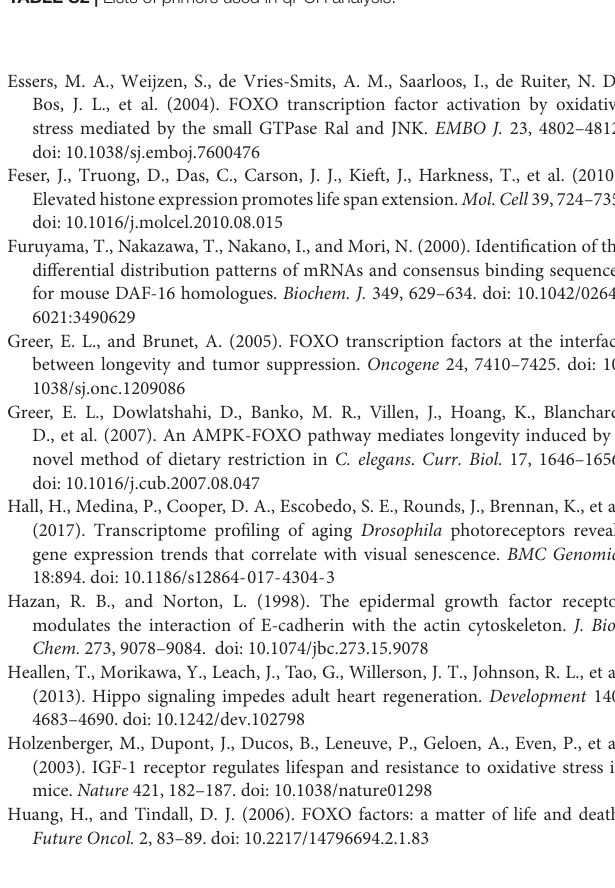
FIGURE S1 | (A) Abdominal fat body and flight muscle of female wild-type flies ( Ore R ) stained with anti-FOXO at ages of 2 weeks and 5 weeks. Scale bar: 20 µ m. (B) FOXO nuclear localization in adult brain of 2-week-old female yw R flies. Scale bar: 100 µ m. FIGURE S2 | (A) The total number of raw reads and Bowtie alignment percentage for individual ChIP-Seq sample. (B) Plot correlation matrix showing the overall correlation among young and aged ChIP and input samples. FIGURE S3 | FOXO target genes in Hippo signaling pathway. Unique FOXO targets in wild-type flies ( yw R ) are highlighted in blue. Unique FOXO targets in chico mutants are highlighted in orange. Shared targets are highlighted in green. FIGURE S4 | FOXO target genes in MAPK/EGFR signaling pathway. Unique FOXO targets in wild-type flies ( yw R ) are highlighted in blue. Unique FOXO targets in chico mutants are highlighted in orange. Shared targets are highlighted in green. TABLE S1 | Lists of peaks, target genes, and GO terms. TABLE S2 | Lists of primers used in qPCR